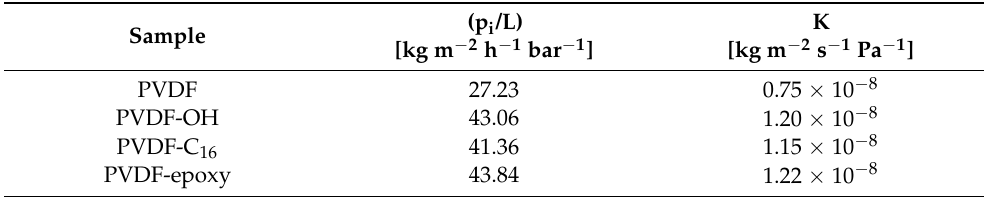
Table 3. Overall mass transfer coefficient and permeability of the investigated membranes.